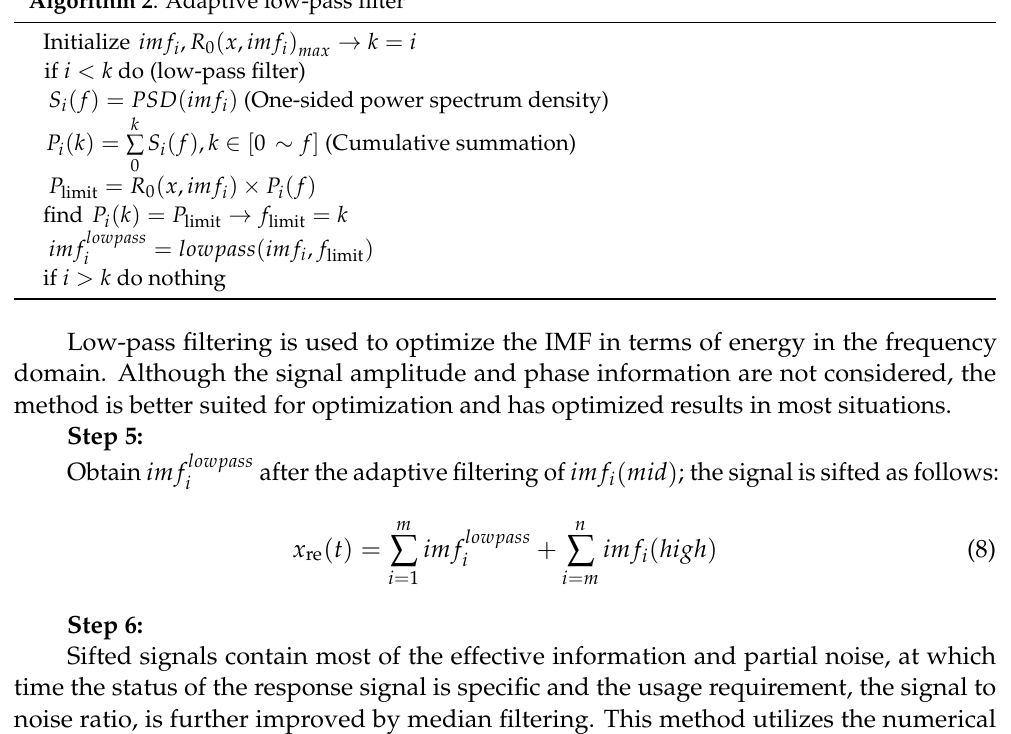
Algorithm 2 . Adaptive low-pass